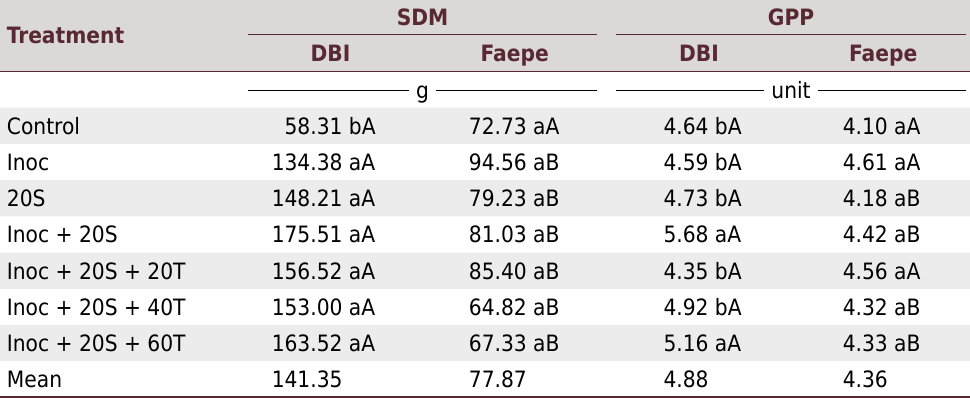
Table 3. Mean values for shoot dry matter (SDM) and grains per pod (GPP) as a function of cultivation site and treatments. DBI and Faepe, 2009